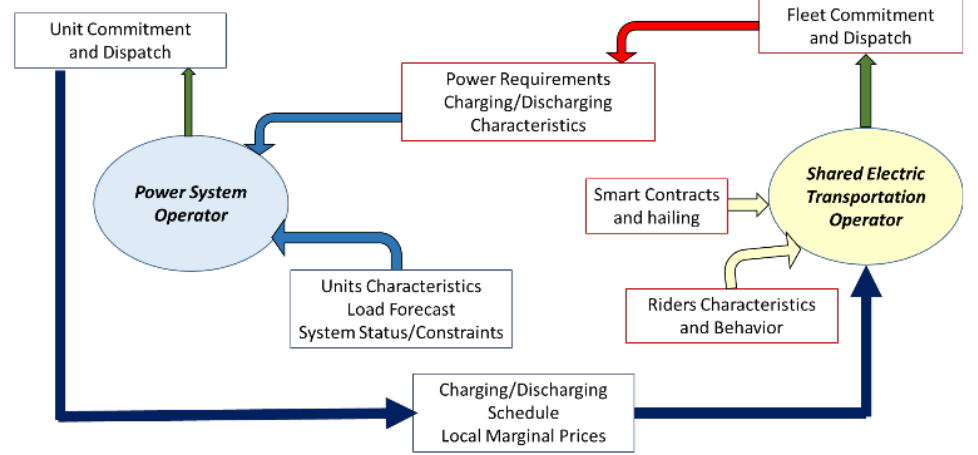
Figure 2. Interaction Between Power System and Electric Fleet